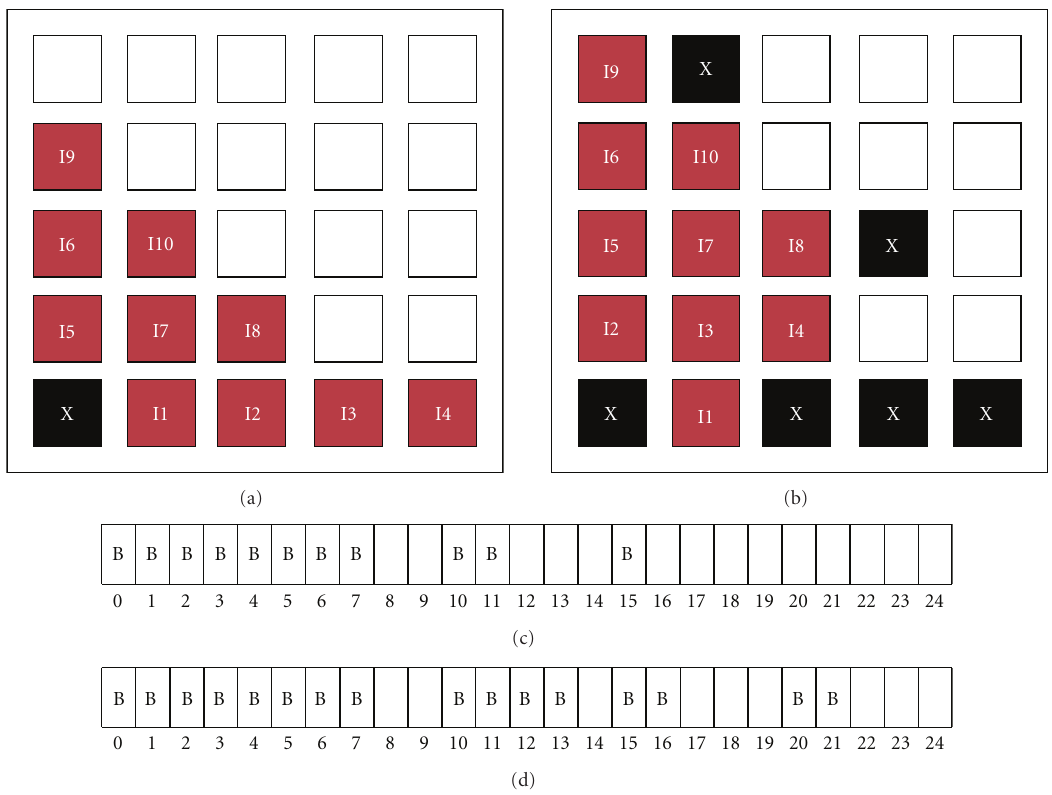
Figure 7: Resource allocation considering defective functional units: (a) not a ff ecting performance, (b) a ff ecting performance, (c) resource map of example (a), and (d) resource map of example (b).